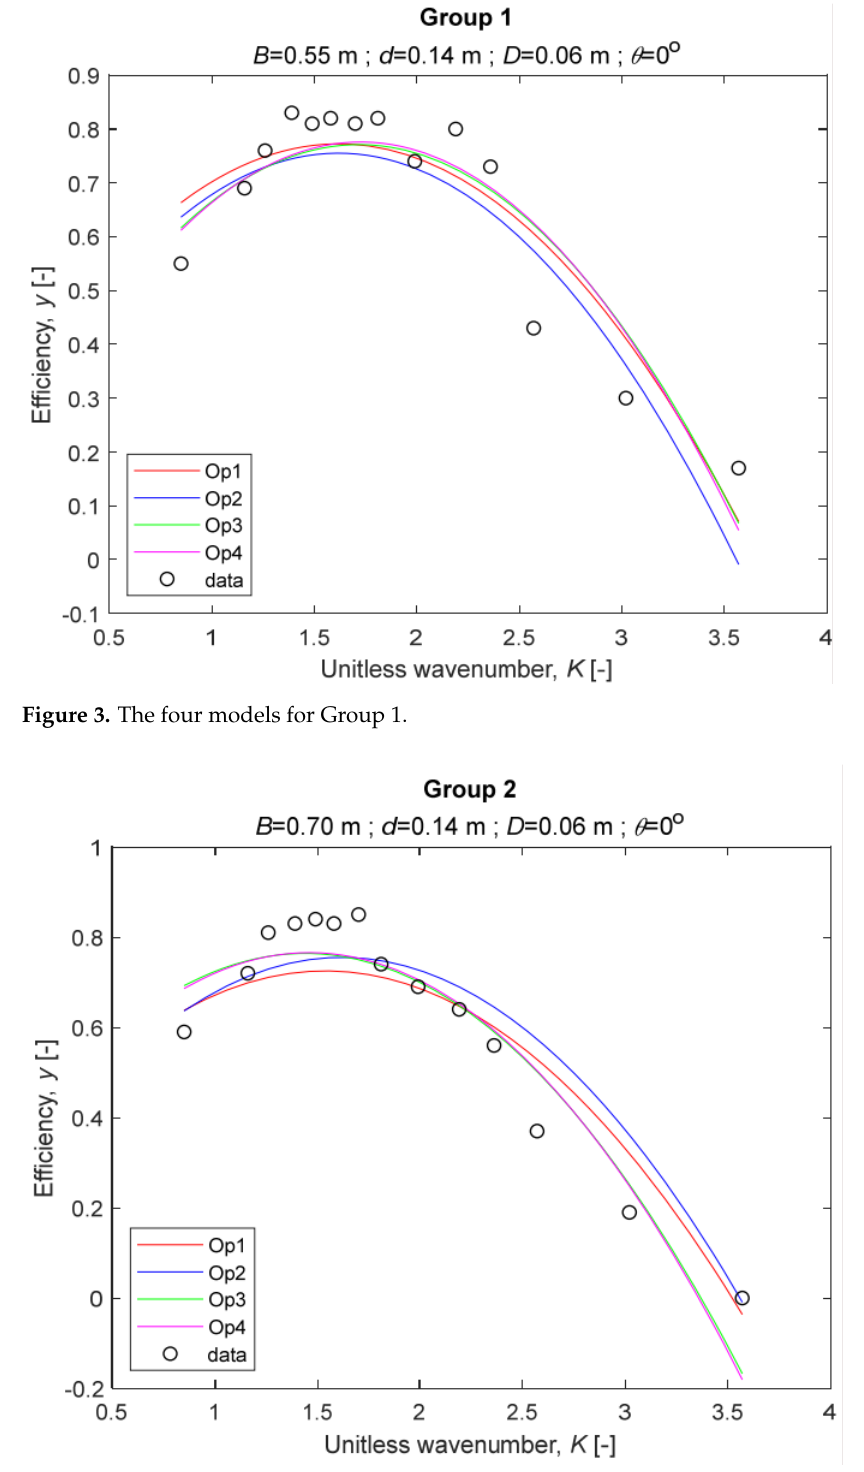
Figure 4. The four models for Group